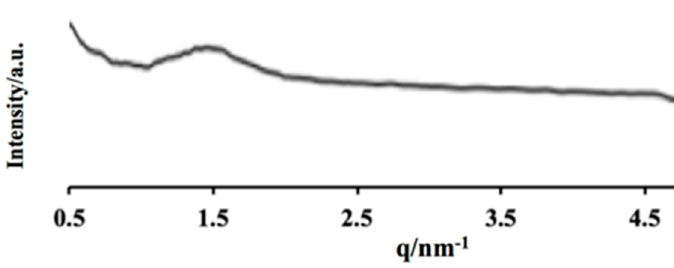
Figure A2. Small Angle X-ray Scattering Analysis (SAXS) profiles of F5 MTZ . Curve is normalized and is horizontally shifted for clarity.